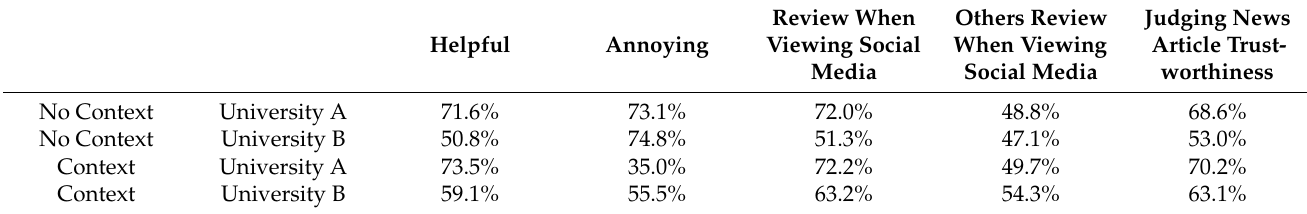
Table 22. Comparison of context versus no context by school.